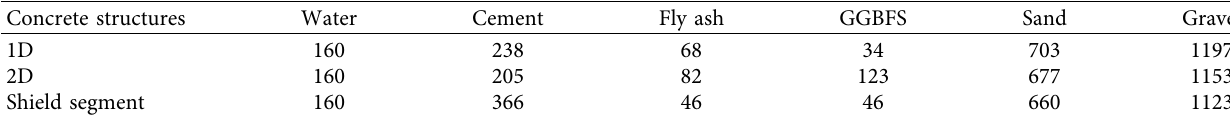
Table 8: Te mix proportion of concrete (kg/m 3 ).